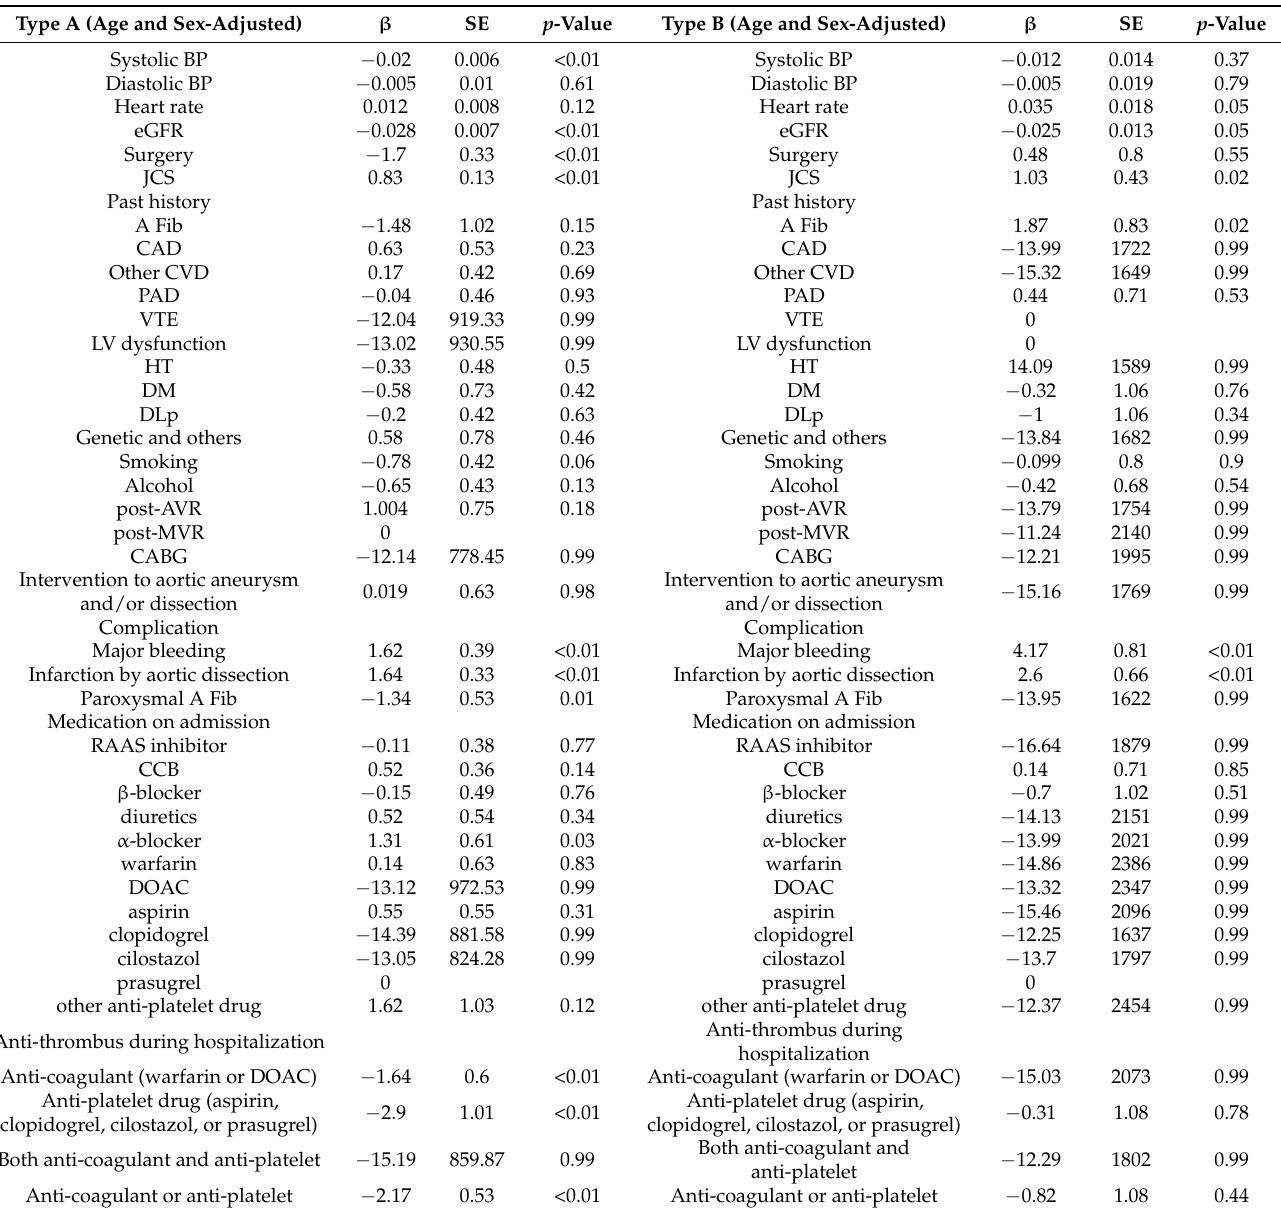
Table 10. Age and sex-adjusted Cox proportional hazard model for all-cause mortality in HOSPITAL- IZED acute aortic dissection